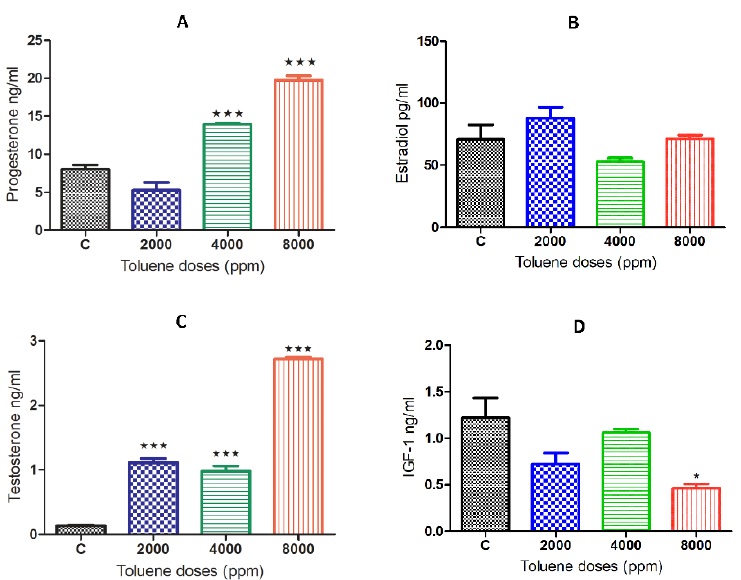
Figure 3. Serum hormone levels of female rats exposed to toluene compared to the control group. The levels of progesterone ( A ) significantly increased in females from the 4000 and 8000 groups, whereas testosterone levels ( C ) significantly increased among all treatments. However, no significant effect of toluene exposure was found on estradiol ( B , D ) IGF1. Values are means ± S.E.M. *, p < 0.05; ***, p < 0.001.